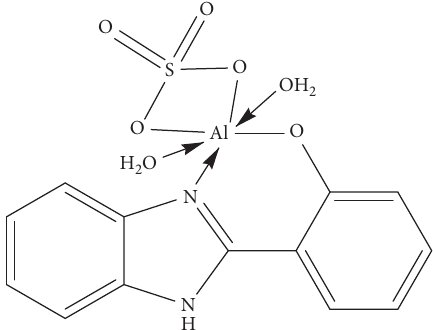
Figure 9: The proposed structure of the synthesized Al +3